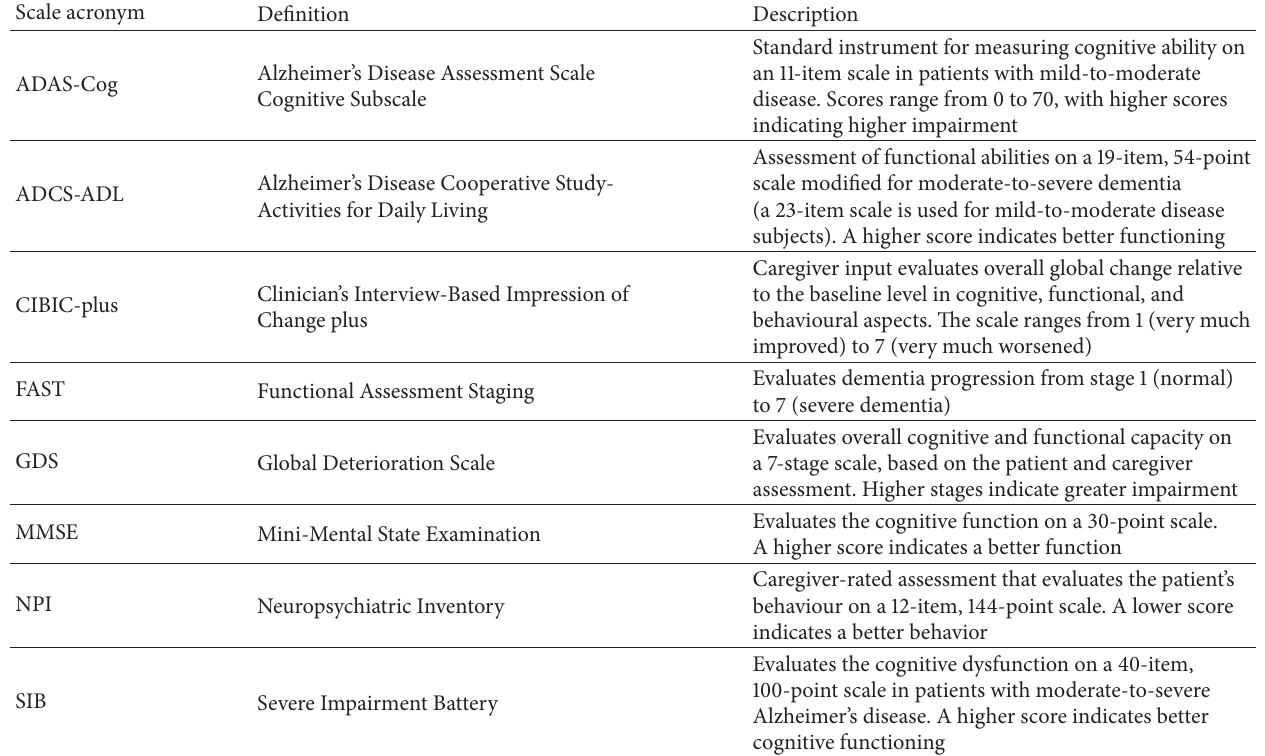
Table 2: Assessment scales mainly used in the clinical trials